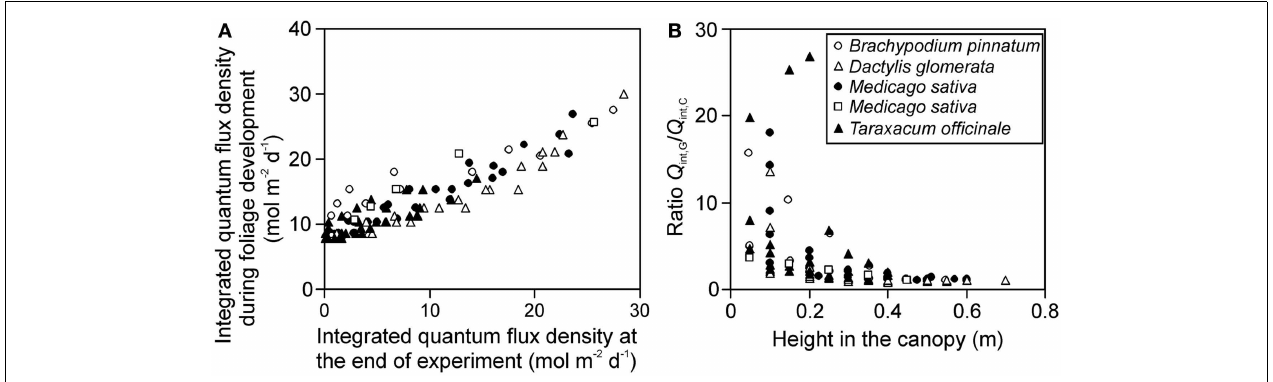
vs. incident quantum flux density relationships (see Measurement of Light Fields of Common Lamps Used in Plant Growth Studies and Estimation of dynamic changes in light profiles in growth chambers”). Data for Brachypodium pinnatum are from Pons et al. (1993), data for Dactylis glomerata , Medicago sativa (filled circles) and Taraxacum officinale are from Lötscher et al. (2003). Data for another experiment in Medicago sativa (open squares) are from Gutschick et al. (Gutschick andWiegel, 1988; Pushnik et al., 1988; Gutschick and Cunningham,